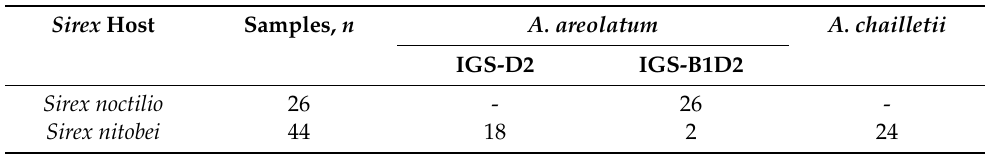
Table 4. Species and IGS strains of Amylostereum associated with Sirex noctilio and Sirex nitobei in the current